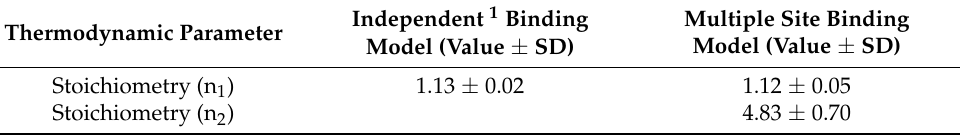
Figure 6. Isothermal titration calorimetry of the interaction between BSP and Sbh26GST. The study was performed at 25 ◦ C whereby 1 mM of BSP was titrated into 50 µ M Sbh26GST. All samples were buffered by 50 mM Tris-HCl, pH 7.2, 2 mM EDTA, 0.02% ( w / v ) NaN 3 , and 1 mM Tris (2-carboxyethyl) phosphine (TCEP). The data were fitted using the independent binding model algorithm implemented in the NanoAnalyze software. Table 2. Thermodynamic parameters from ITC analysis of the interaction between BSP and Sbh26GST. The study was performed at 25 ◦ C whereby 1 mM of BSP was titrated into 50 µ M Sbh26GST. All samples were buffered by 50 mM Tris-HCl, pH 7.2, 2 mM EDTA, 0.02% ( w / v ) NaN 3 , and 1 mM Tris (2-carboxyethyl) phosphine (TCEP). Two binding models were used to fit the binding